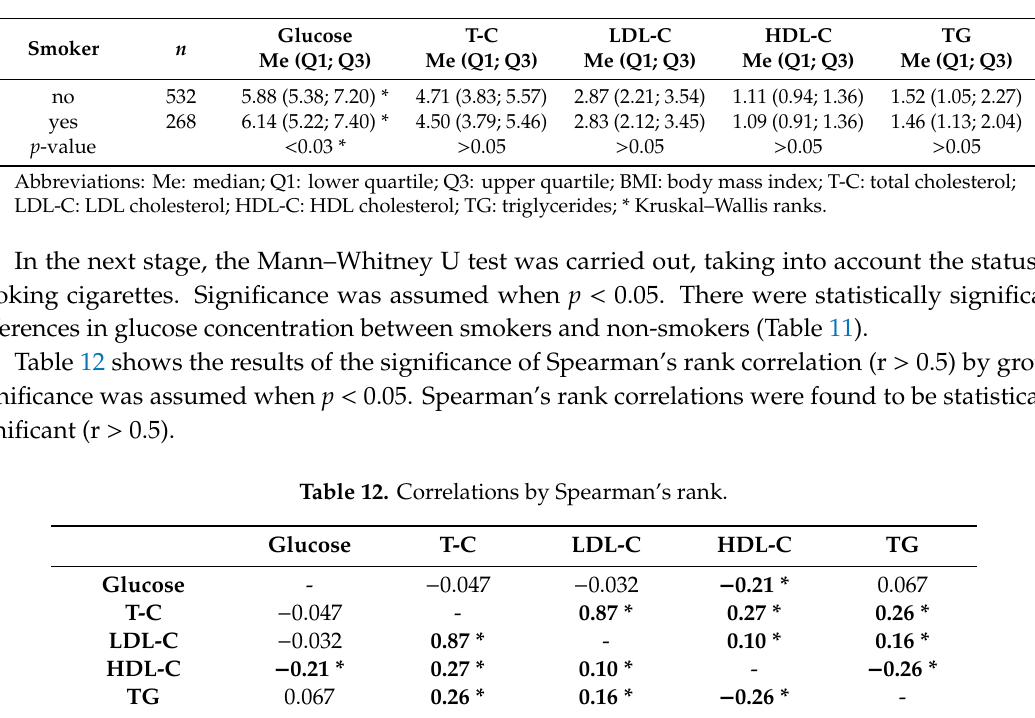
Table 11. Kruskal–Wallis rank ANOVA analysis by smoker group.